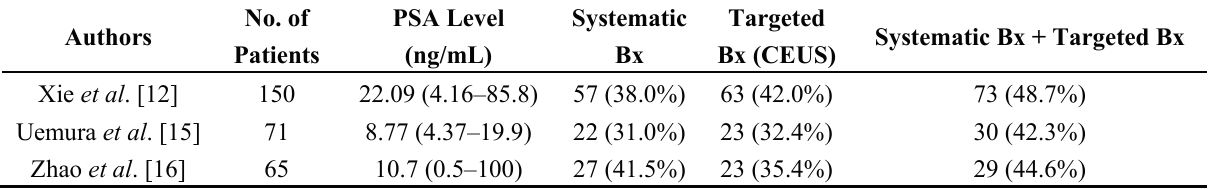
Table 2. CEUS studies of prostate cancer (prostate biopsy